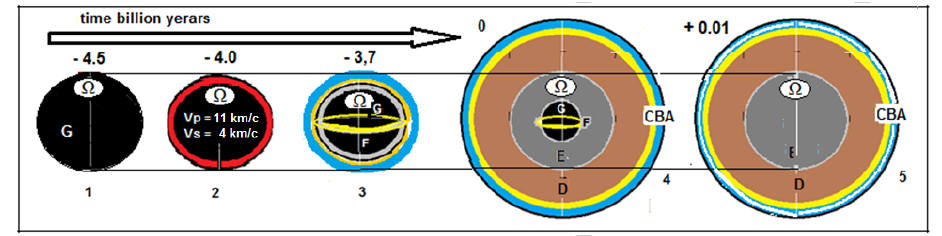
Fig. 6. Cooling of the hot, total quantum-entangled Earth from its formation 4.5 billion years ago up to nowadays approximated to the following 5-10 million years, after which the geomagnetic field will disappear.